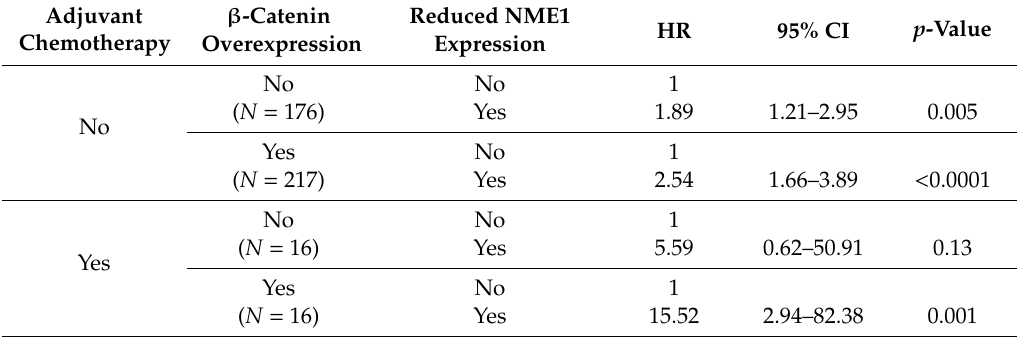
Table 1. Cox proportional hazards analysis a of RFS according to NME1 in early stage NSCLC stratified by cisplatin-based adjuvant chemotherapy and β -catenin overexpression Adjuvant